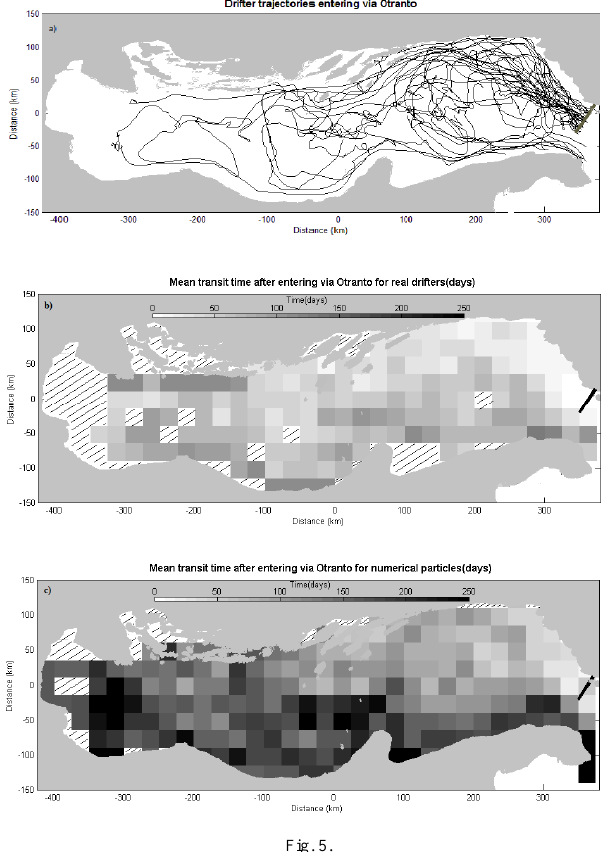
Fig. 5. Trajectories of the real drifters entering the Adriatic Sea (a) . Geographical distribution of the mean transit time after en- tering on the eastern side of the Otranto Channel (through section shown with black line), estimated from real drifters (b) and numer- ical particles (c)